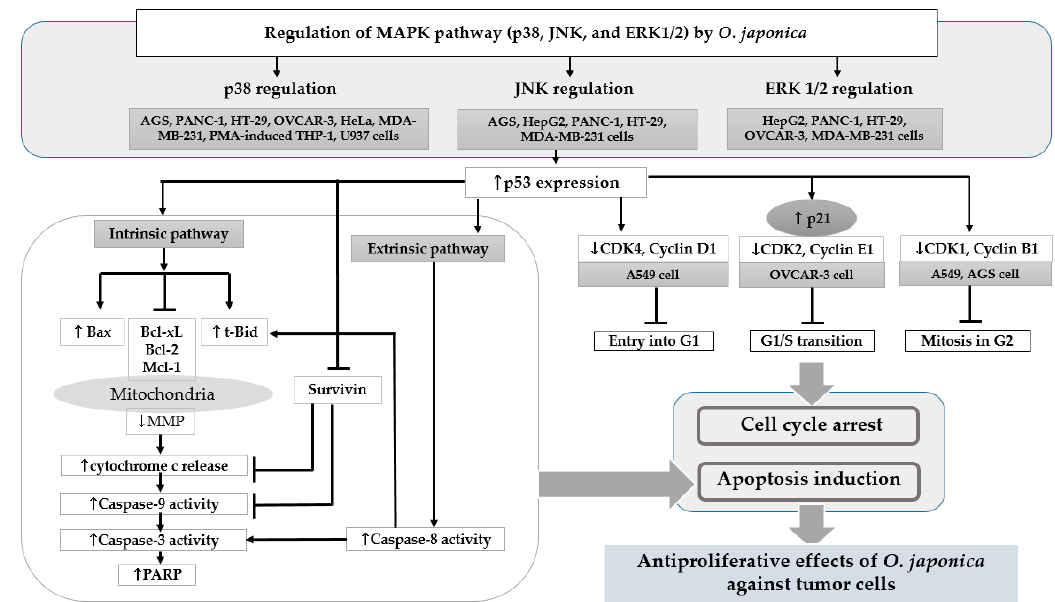
Figure 1. Mechanism of pro-apoptosis and cell cycle arrest induced by Orostachys japonica related to its antiproliferative effects. As shown, the regulation of MAPK expression in the presence of O. japonica against tumor cells causes an increase in p53 tumor suppressor gene expression. This modulation also results in apoptosis induction through intrinsic/extrinsic pathways and serine, fatty acid, and glucose metabolism in tumors. Similarly, cell cycle arrest at G1, the G1/S transition, and the G2 phase is induced by decreasing the expression of cyclins and CDKs. MAPK: mitogen-activated protein kinases; Bax: Bcl2-associated X protein; Bcl: B-cell lymphoma; Mcl: myeloid cell leukemia; t-Bid: truncated BH3-interacting domain death agonist; MMP: matrix metallopeptidases; PARP: poly ADP ribose polymerase; PHGDH: D-3-phosphoglycerate dehydrogenase; FASN: fatty acid synthase; CDK: cyclin-dependent kinase.